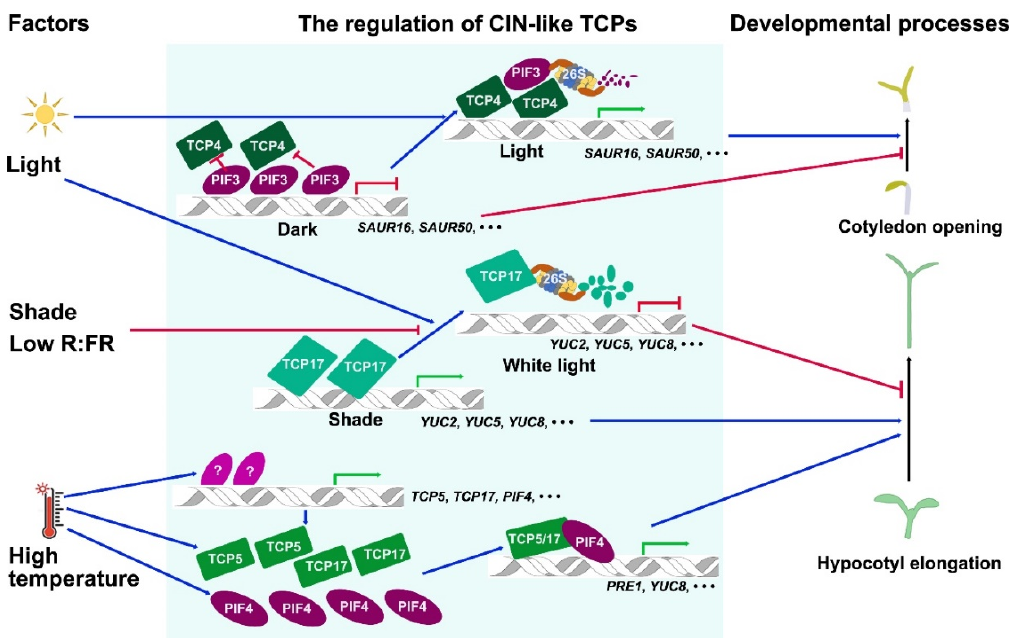
Figure 2. An overview of the regulation mechanisms of CIN-like TCP transcription factors by light and temperature during cotyledon opening and hypocotyl elongation processes. The external stimuli including light and high temperature are summarized at the left column. The schematic diagram includes the regulation mechanisms of CIN-like TCPs at the transcriptional and the protein levels. The arrows directly pointing on the double helix symbols indicate transcriptional regulations. The arrows pointing to the proteins indicate the regulations of protein stabilities. The proteins related with the “26S” symbols indicate protein degradation through the ubiquitin-26S proteasome pathway. The blue arrows represent the positive regulation, and the red arrows with dash-headed ends indicate the negative regulation. The green arrows and red dash-headed ends at the double-helix icons indicates the activation and repression of gene expression, respectively. All the unknown factors are indicated with question marks. R:FR, red light: far red light ratio; PIFs, PHYTOCHROME-INTERACTION FACTORs; SAURs, SMALL AUXIN UPREGULATED RNAs; YUCs, YUCCAs.